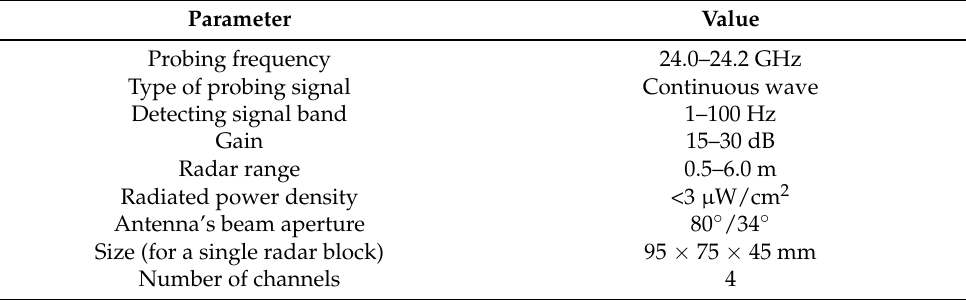
Table 1. Technical characteristics of the bioradar system.